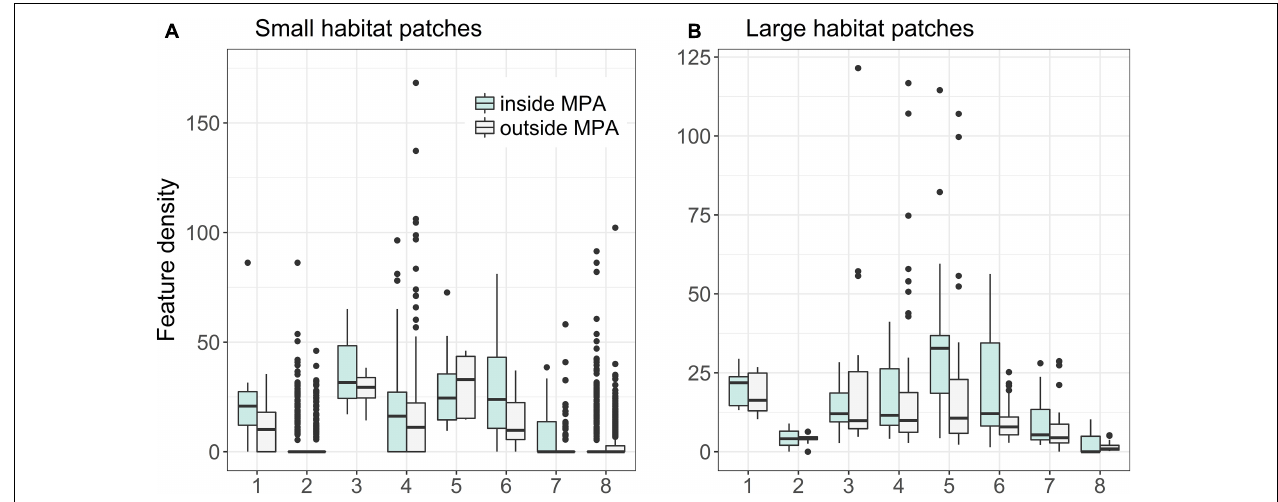
FIGURE 11 | Quality of patches of marine habitats based on Zonation LSM-analysis (see details in section “Analysis Variants and Post-processing”). Marine habitats: (1) Baltic esker islands, (2) Boreal Baltic islets, (3) Boreal Baltic narrow inlets, (4) Coastal lagoons, (5) Estuaries, (6) Large shallow inlets and bays, (7) Sand banks, and (8) Reefs. (A,B) Show feature densities for smaller (0.16–0.999 km 2 ) and larger ( ≥ 1 km 2 ) habitat patches,